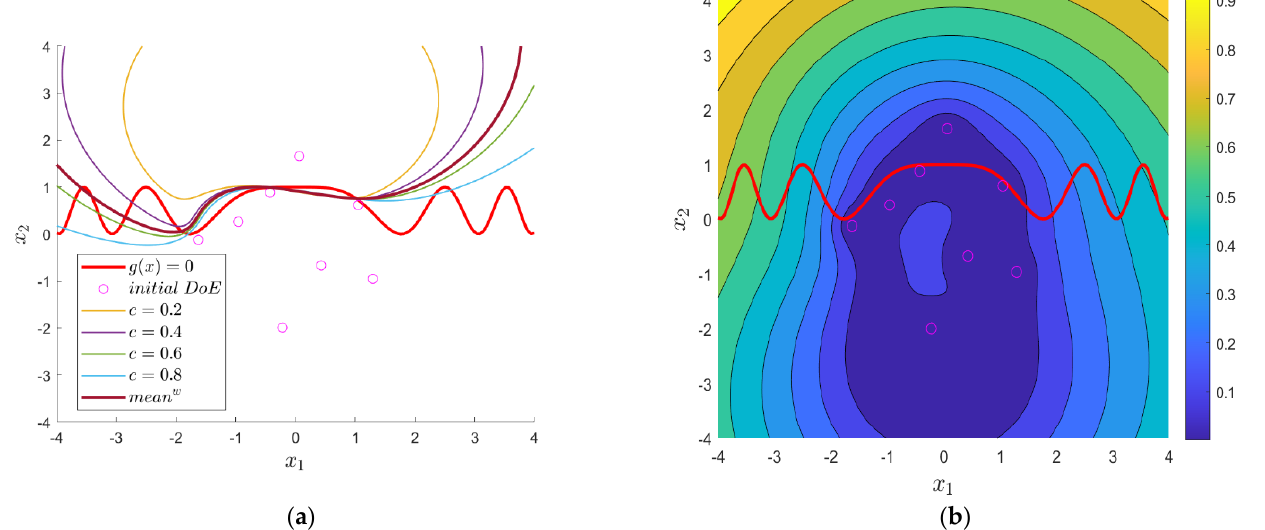
Figure 3. Steps 1–3 of the demonstrated problem. ( a ) LSF of the weighted of RBF models corresponding to c = 0.2, c = 0.4, c = 0.6, and c = 0.8 and mean w . ( b ) Contour map of the weighted prediction